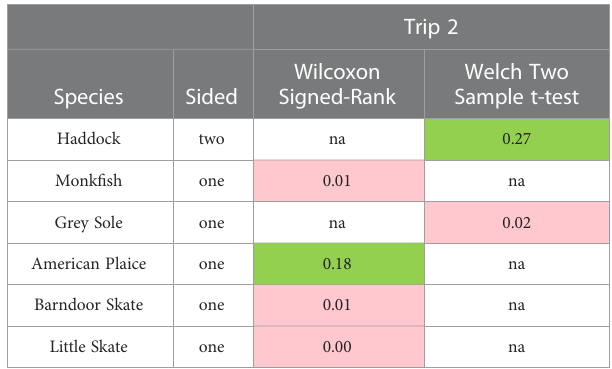
TABLE 4 Test statistics for signi fi cance comparing species ’ paired catches between the OBT net and the Ruhle